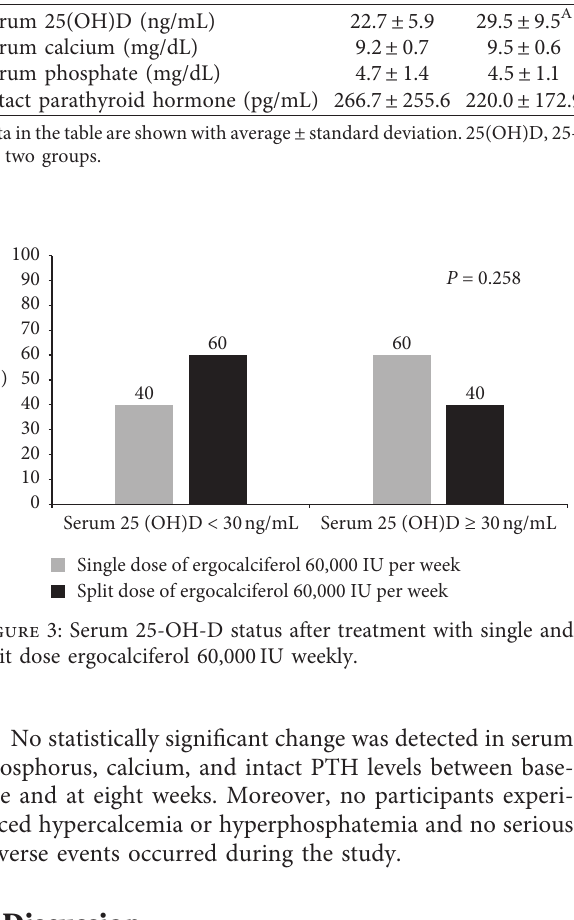
Table 2: Outcomes between split and single dose of ergocalciferol 60,000IU weekly supplement at 8 weeks. Parameters